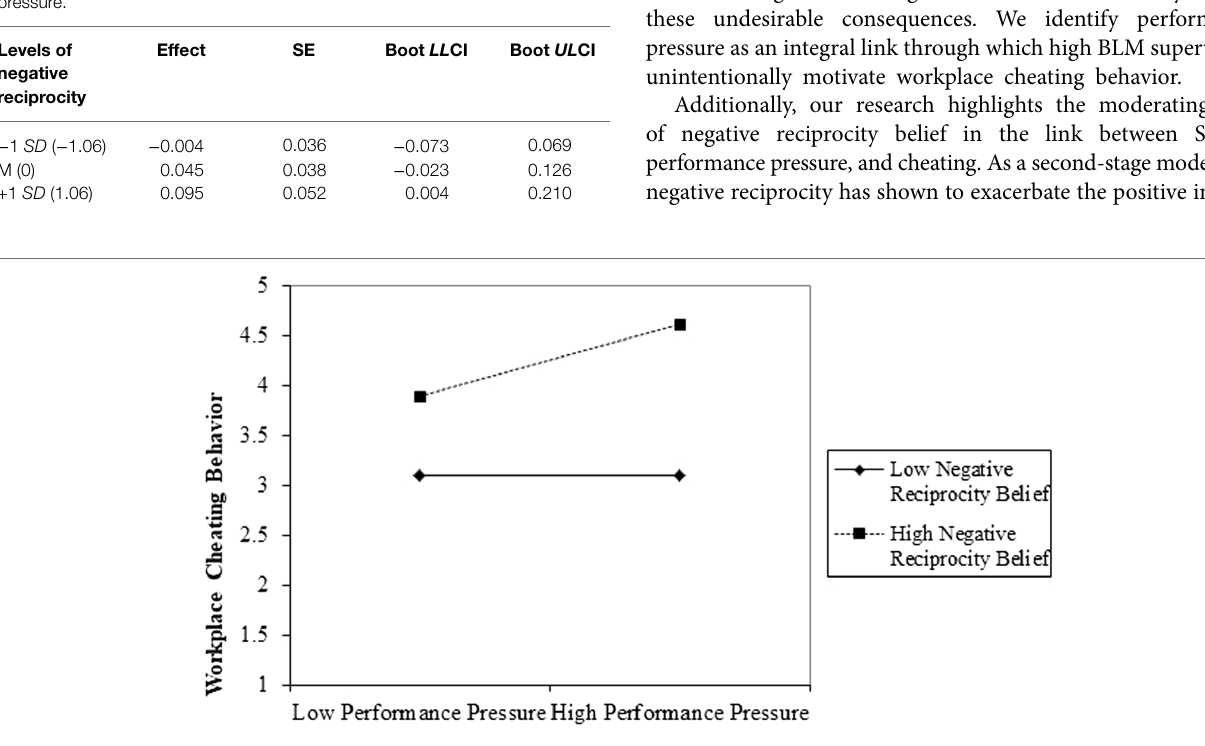
FIGURE 2 | The moderating effect of negative reciprocity on the relationship between performance pressure and employee cheating.